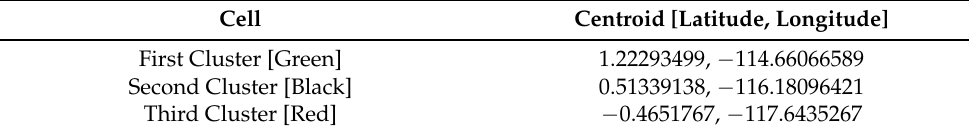
Figure 11. 49,000 UE clustered based on their location: Cell type, latitude, and longitude. Table 2. Centroid of each